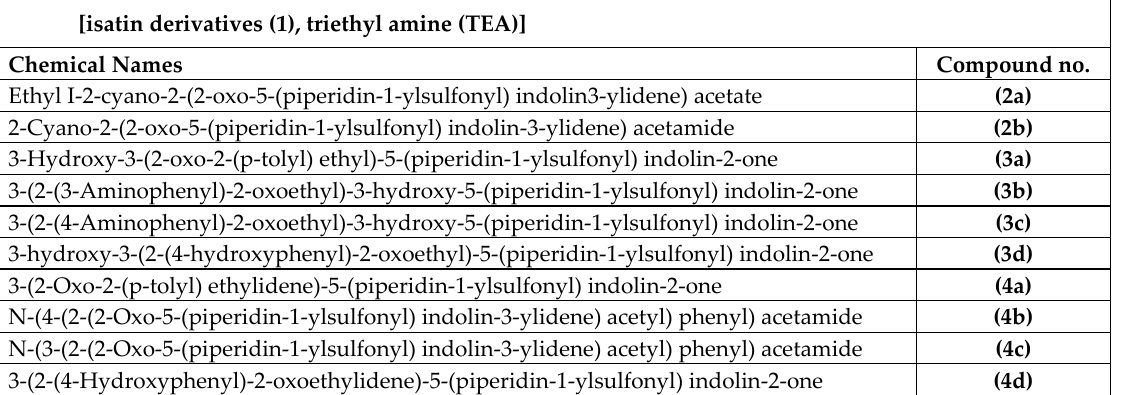
Figure 1. Synthetic routes scheme for arylidine and 3-hydroxy-3-substituted isatin sulfonamide and 2-oxindole as well as 3-phenacylidene-2-indolinone derivatives with their chemical